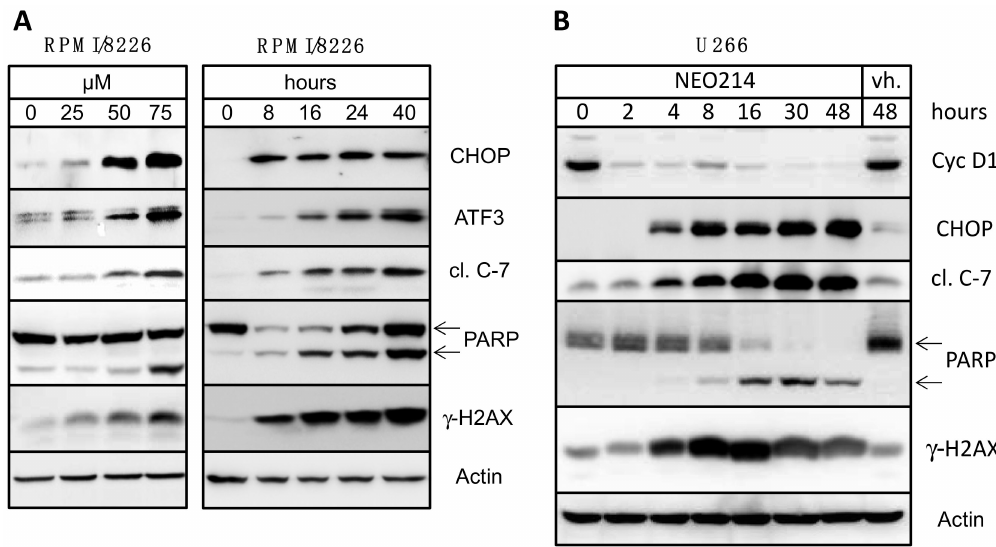
Figure 5. NEO214 induces markers of ER stress and apoptosis. ( A ) RPMI/8226 cells were treated with increasing concentrations of NEO214 for 24 h (left panel) or with 100 µ M NEO214 for different times (right panel). ( B ) U266 cells were treated with 100 µ M NEO214 for different times, and with vehicle only (vh.) for 48 h. In all cases, cell lysates were prepared and subjected to Western blot analysis with specific antibodies as indicated. Actin was used as the loading control. cl. C-7: cleaved caspase 7 (band represents active fragment). Two arrows point to full-length and cleaved form of poly-ADP-ribose polymerase (PARP). CHOP, CCAAT/enhancer-binding protein homologous protein; ATF3, activating transcription factor 3, γ H2AX, phosphorylated form of histone variant H2AX